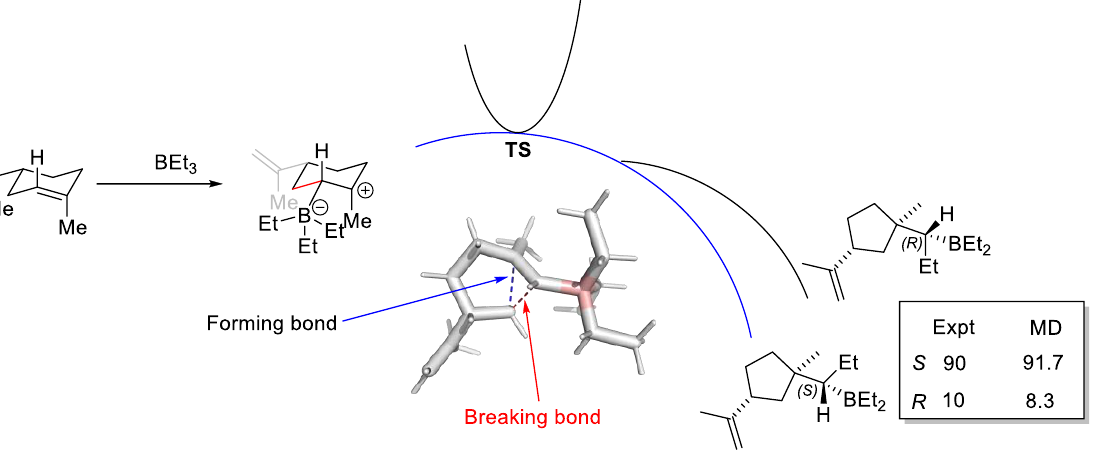
Figure 14. Singleton and co-workers reported an example of bifurcation leading to two stereochem- ical outcomes [135]. MD: selectivity predicted by a series of molecular dynamics simulations (all values are obtained from their work).